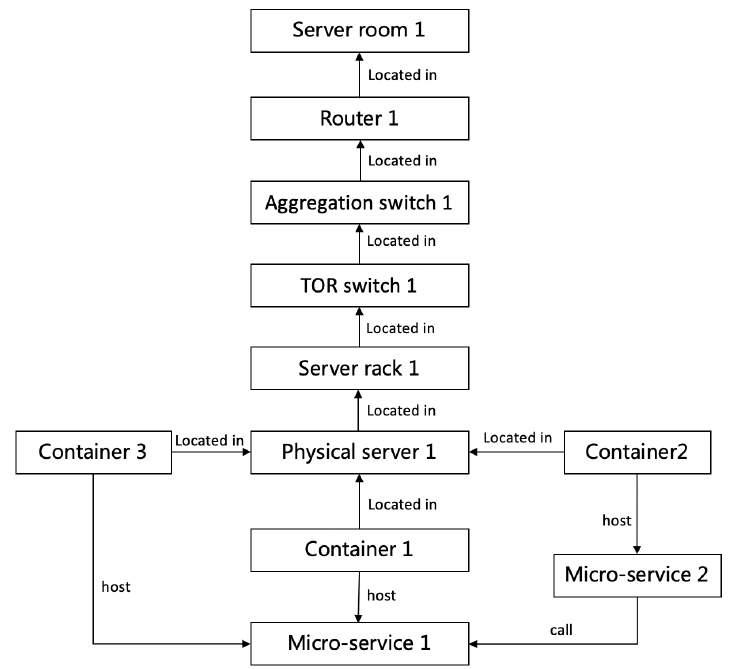
Figure 2. Sample knowledge graph of software and hardware subjects for an MSA application.